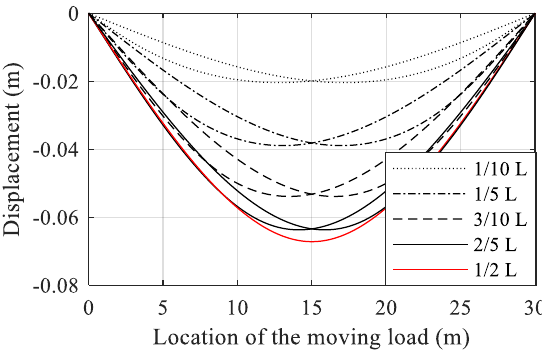
Figure 5. Displacement influence lines (ILs) obtained by 9 sensors for a healthy